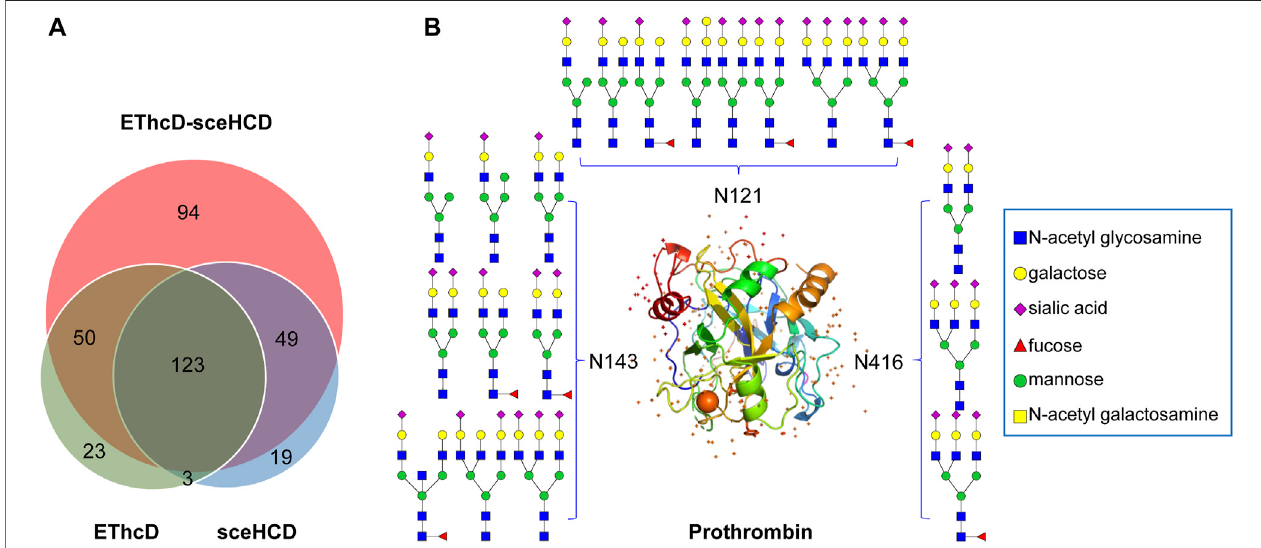
FIGURE 5 | Global analysis of identi fi ed plasma intact N-glycopeptides. (A) Comparison of identi fi ed intact N-glycopeptides using EThcD, secHCD, and EThcD- sceHCD. (B) N-glycosites(N121,N143,andN416)anddeducedN-glycansweredemonstratedinthethree-dimensionalstructureoftheprothrombin(PDBcode:1A2C) from pooled PCa patients ’